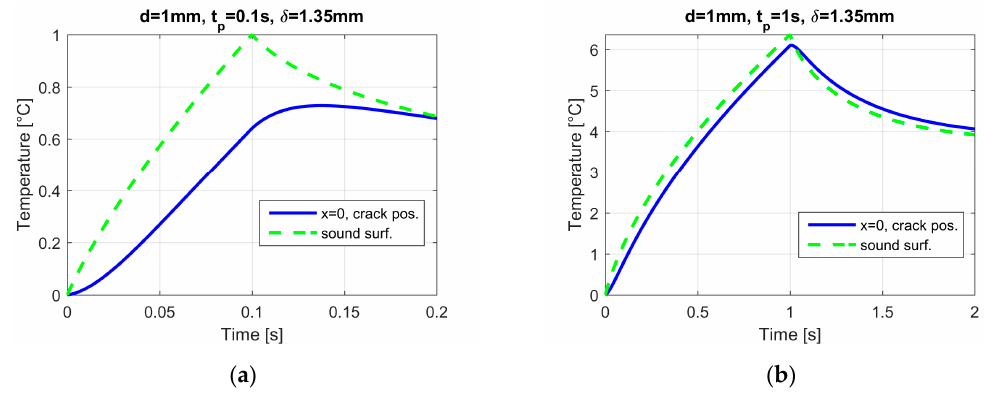
Figure 21. Temperature at the crack position and at the sound surface distribution for 0.1 s ( a ) and 1 s ( b ) heating pulses for the same scenario shown in Figures 18 and 20.